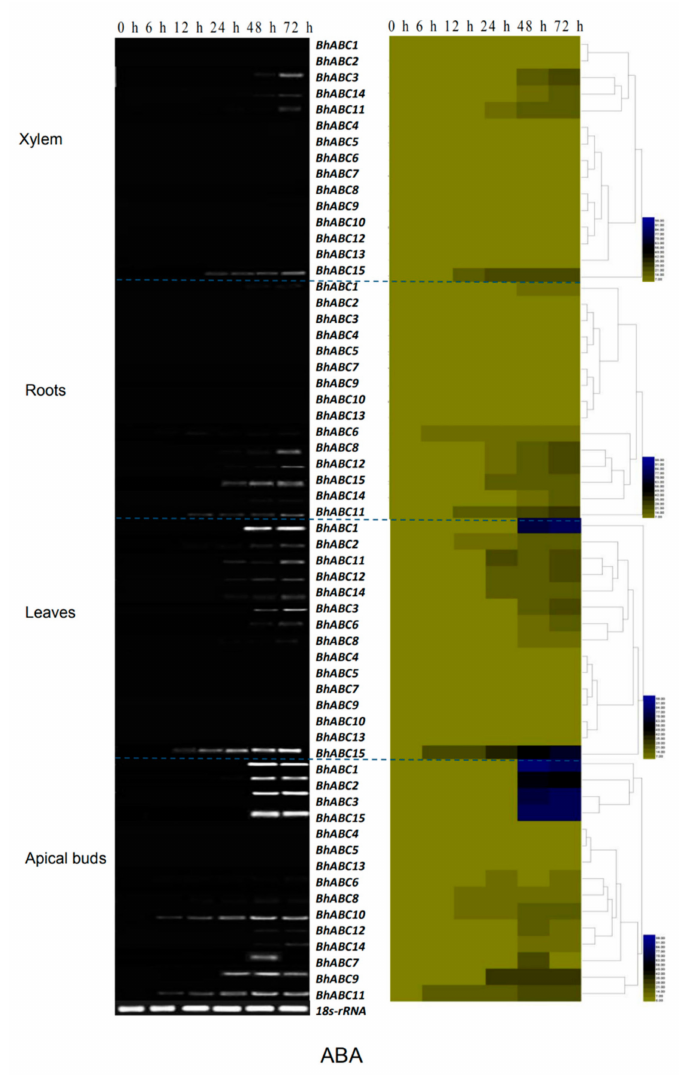
Figure 9. Expression patterns of BhABC genes in xylem, roots, leaves, and apical buds after ABA treatment. Heat map showing responses of BhABC genes to ABA (right); semi-quantitative RT-PCR analysis with 18s RNA internal reference